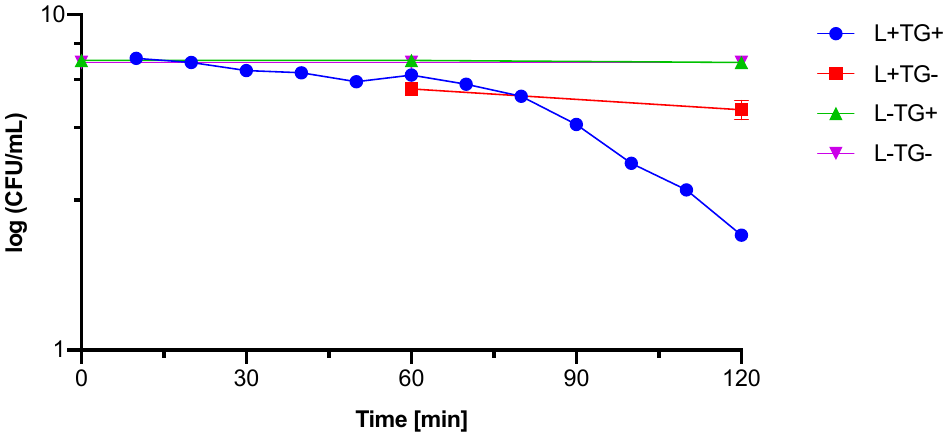
Figure 9. The inactivation of S. aureus with TiO 2 -GA and visible light ( λ = 425 nm) irradiation in function of time. Where: L+ is the irradiated sample; L − is the non-irradiated sample (tested in the dark); TG+ is the sample with photosensitizer (TiO 2 -GA); TG − is the sample without photosensitizer.